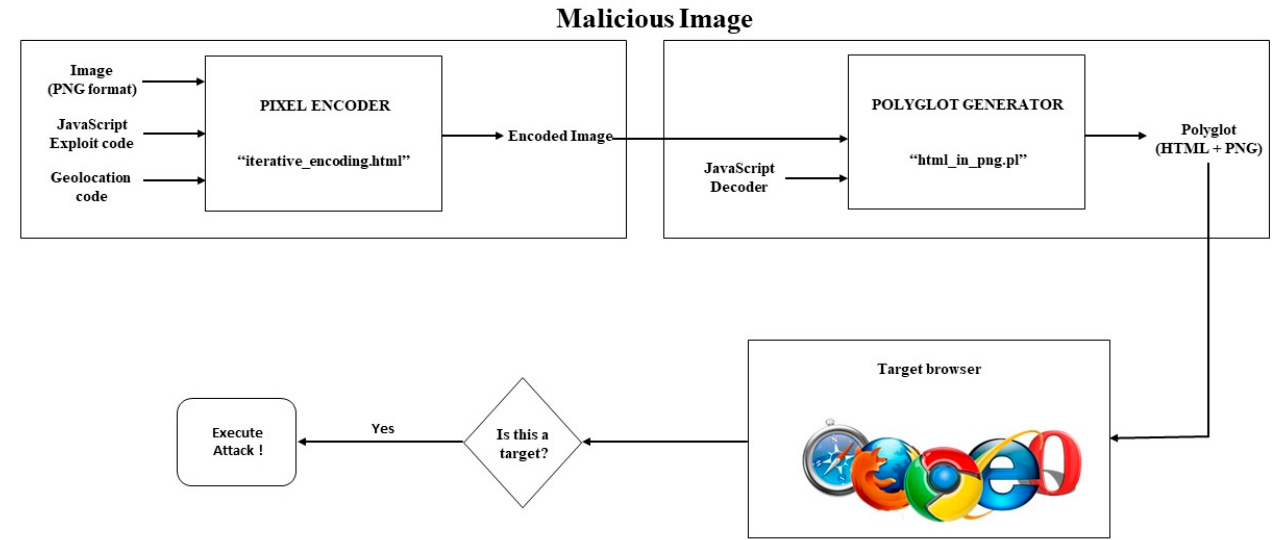
Figure 2. A block diagram of the proposed attack.